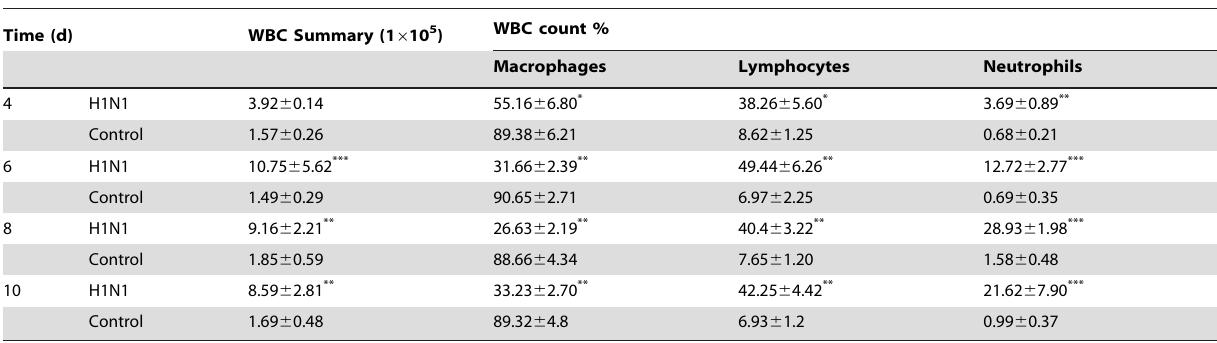
Table 2. White blood cell (WBC) summary and differential counts in BALF.